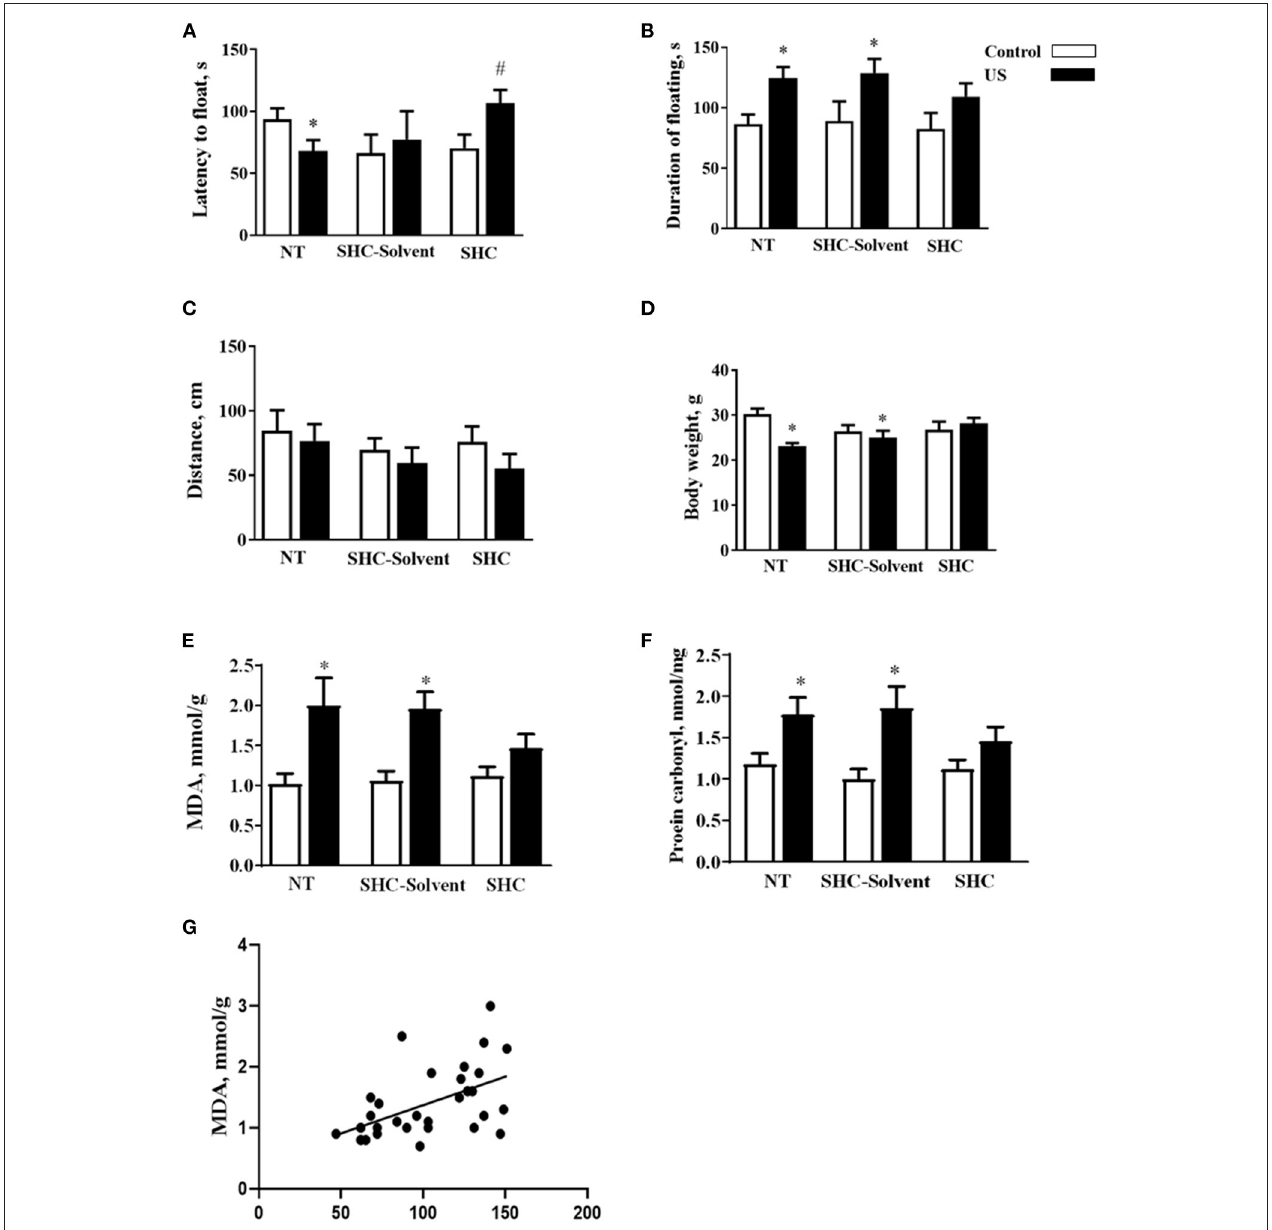
FIGURE 3 | Ultrasound exposure of C57BL/6 mice induces abnormal behaviors and neuroinflammation: changes that are prevented by herbal antioxidant treatment. (A) Mice exposed to US that received no treatment but not stressed SHC-treated mice showed a significant prolongation of this behavior in comparison with controls. (B) In the open field, the number of rearings was significantly lower in nontreated US mice but not in US SHC-treated than in control. In the elevated O-maze, (C) the time spent in the open arms and (D) the number of exits therein were decreased in US nontreated animals in comparison with controls that was not found in US SHC-treated mice. (E) Several markers of inflammation and distress were studied for their gene expression in the prefrontal cortex. US-induced gene overexpression of IL-6 and IL-1 β was ameliorated by SHC administration. (F) We found that US-exposed mice display the upregulation of several markers of inflammation and distress on a protein level. The overexpression of IL-6 and IL-1 β , but not GSK-3 α was normalized in the US SHC mice * p < 0.05 vs. nontreated nonstressed controls, # p < 0.05 vs. nontreated stressed group, one-way ANOVA and post-hoc Tukey’s test. (G) The concentration of MDA significantly correlated with the duration of floating behaviour. Con, control nonstressed nontreated group. Bars are mean ± SEM.